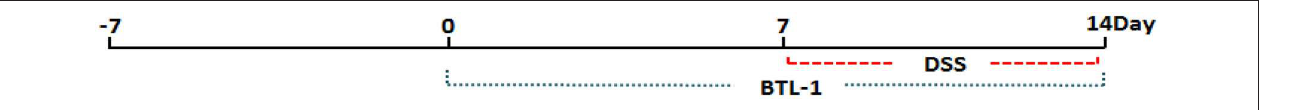
effect of BTL-1 on intestinal inflammation and its protective effect on intestinal barrier